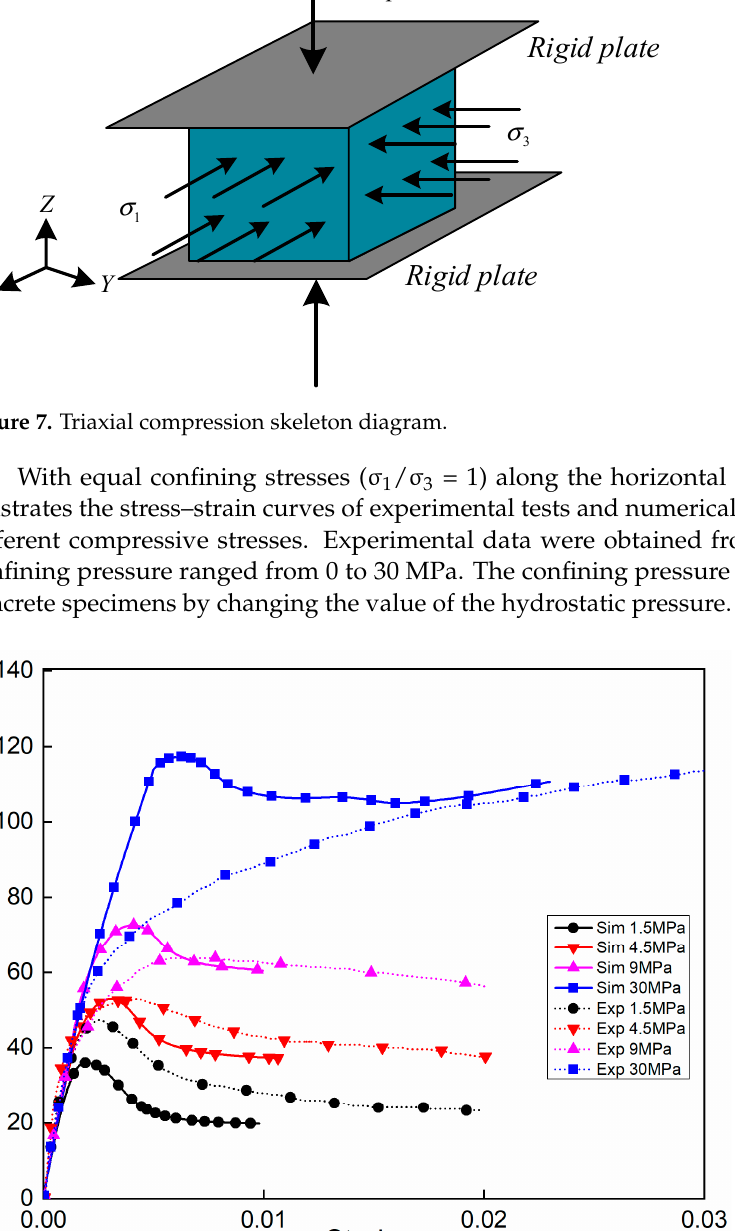
Figure 8. Comparison of the stress–strain curves between the experiments and simulations. The stress–strain curves changed with the increasing confining pressure. With low confining pressures, the stress–strain curves had clear peak stress points and then experienced the falling stage. Beyond the peak stresses, the softening stages increased with the increasing confining pressures and the stress during the softening stage tended to be stable. Under the confining pressure of 9 MPa, there were no significant descending stages in the curves. When the confining pressure continued to increase to 30 MPa, which was close to the uniaxial compressive strength, the maximum stress of the softening stage could exceed the peak stress, as shown in Figure 8. At that time, the curve went up continuously as the strain increased, but the growth rate of the stress, which is represented by the slope of the curve, decreased gradually and approached 0. Under low confining pressures, the concretes exhibited a brittle fracture feature. With sufficiently large confining pressures, the brittle behaviour of the concretes would disappear, preventing